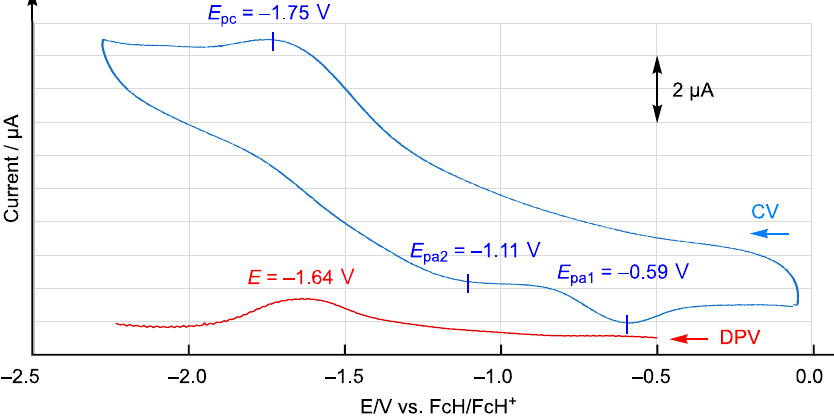
Figure 4. Cyclic (blue) and differential-pulse (red) voltammograms of spirogermabifluorene 1 in THF at − 40 °C ([ 1 ]: 1.0 mM; supporting electrolyte: 0.1 M [ n Bu 4 ][PF 6 ]; scan rate: 70 mVs − 1 ).